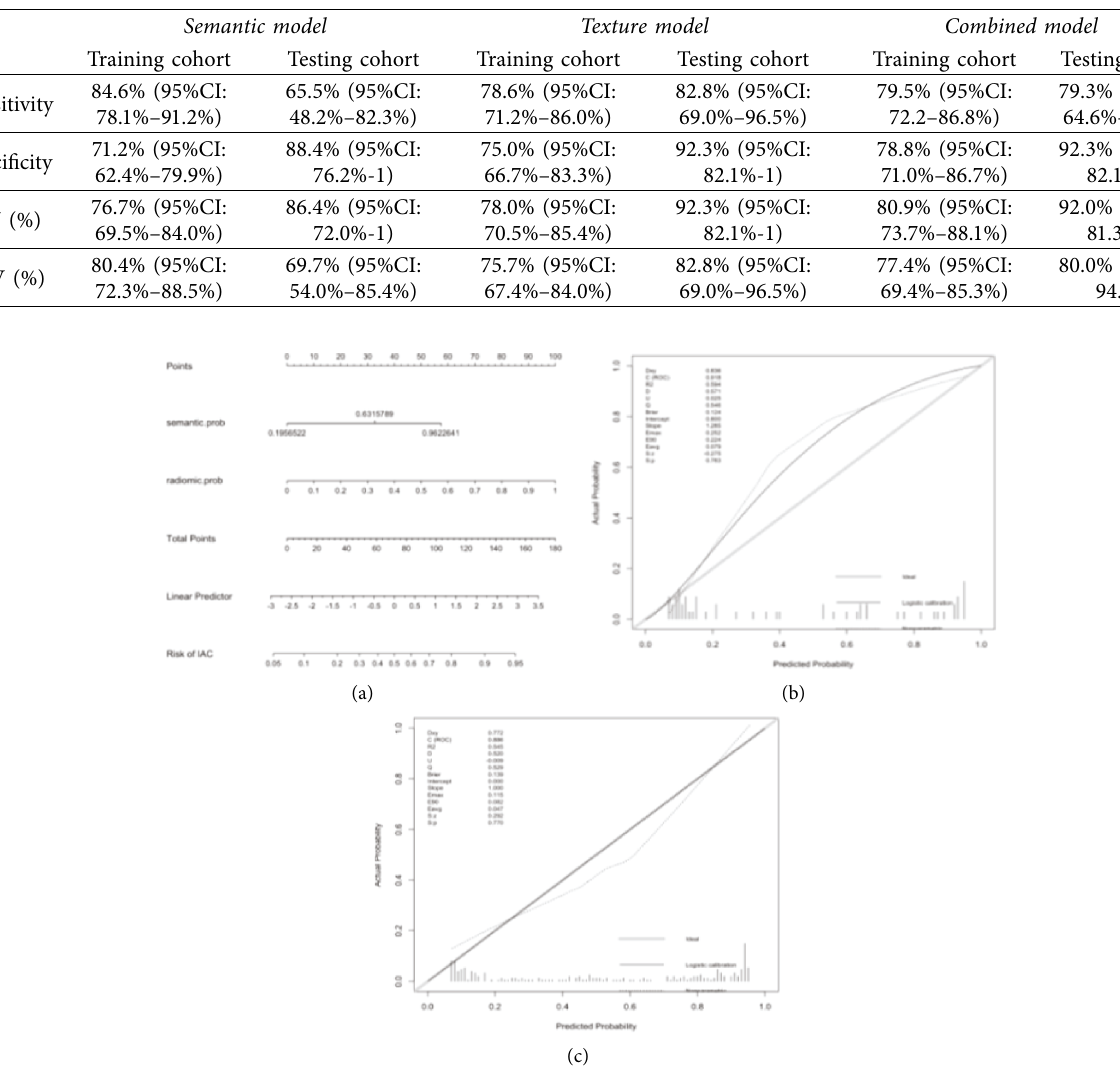
Figure 6: Nomogram of the combined model constructed in our training cohort. The semantic and texture signatures were incorporated as factors (a). The calibration curves show a good agreement between the model predicted and actual probability of being an invasive nodule in the training cohort (b) and testing cohort (c).